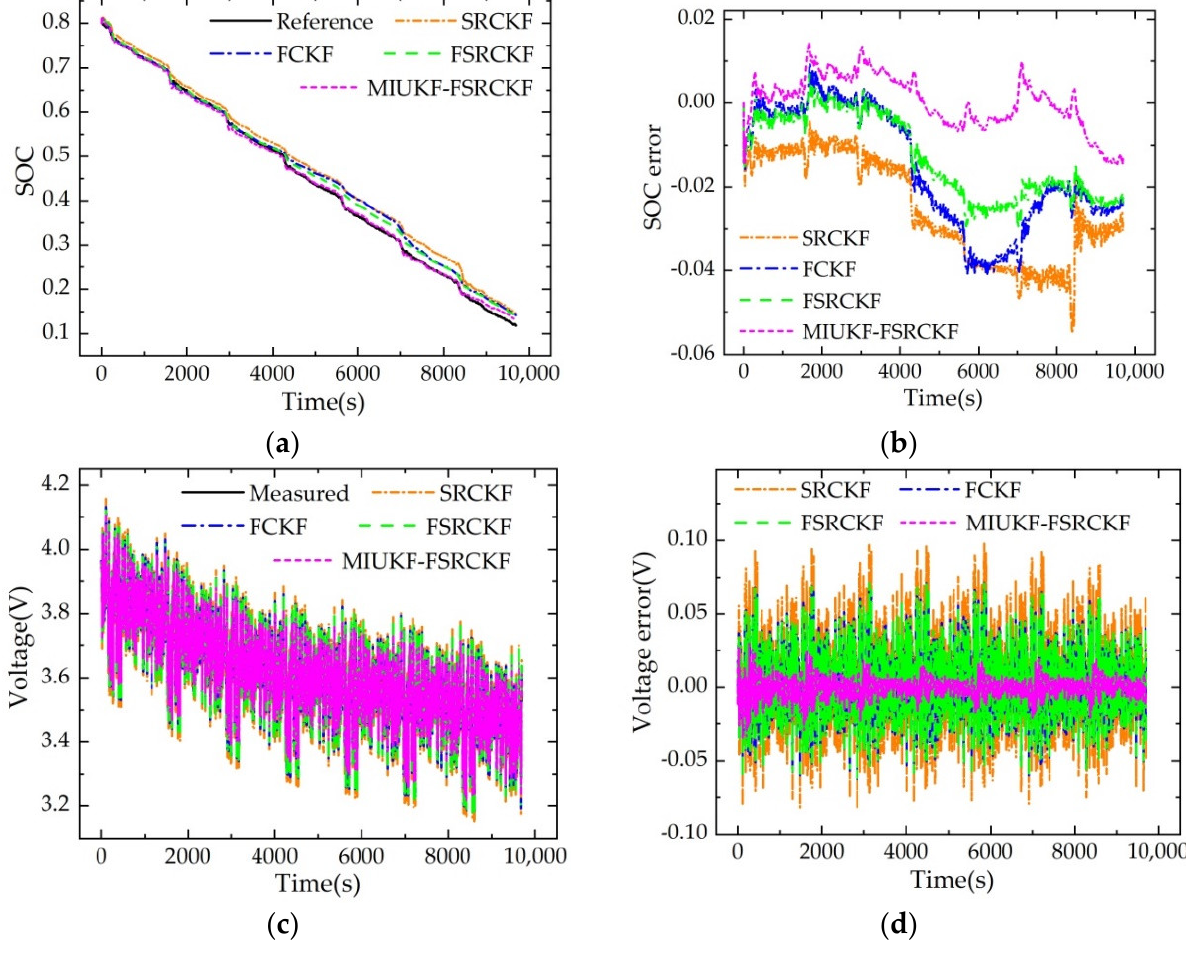
Figure 10. Comparison of the results of the four algorithms under the FUDS test. The identified R 0 is increased by 20% as the initial value of R 0 : ( a ) SOC estimation result; ( b ) SOC error; ( c ) voltage estimation result; ( d ) voltage error. Table 6. SOC error and voltage error of each algorithm under the FUDS test. (The identified R0 by AGA is increased by 20% as the initial value of R0.)